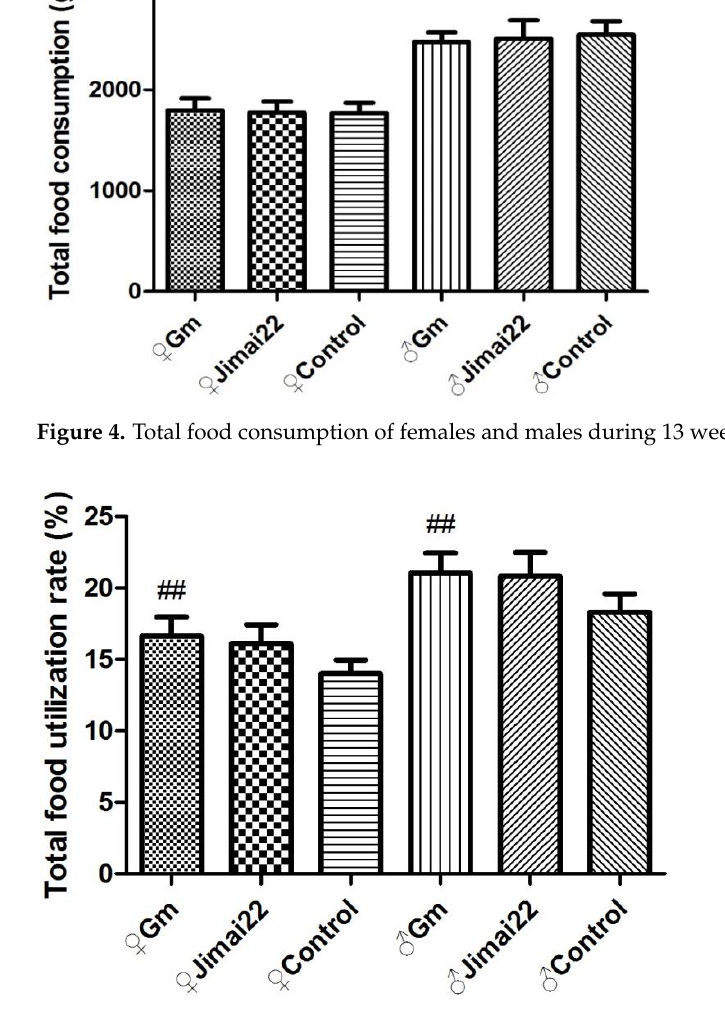
Figure 5. Total food utilization of females and males during 13 weeks. ## represents p < 0.01 compared with control group.